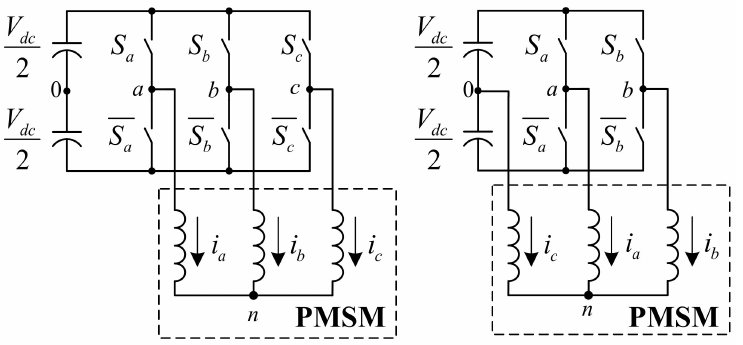
Figure 1. Inverter basic for the 6S3P topology ( left ); fault-tolerant reconfiguration of phase C in the 4S3P topology ( right ).